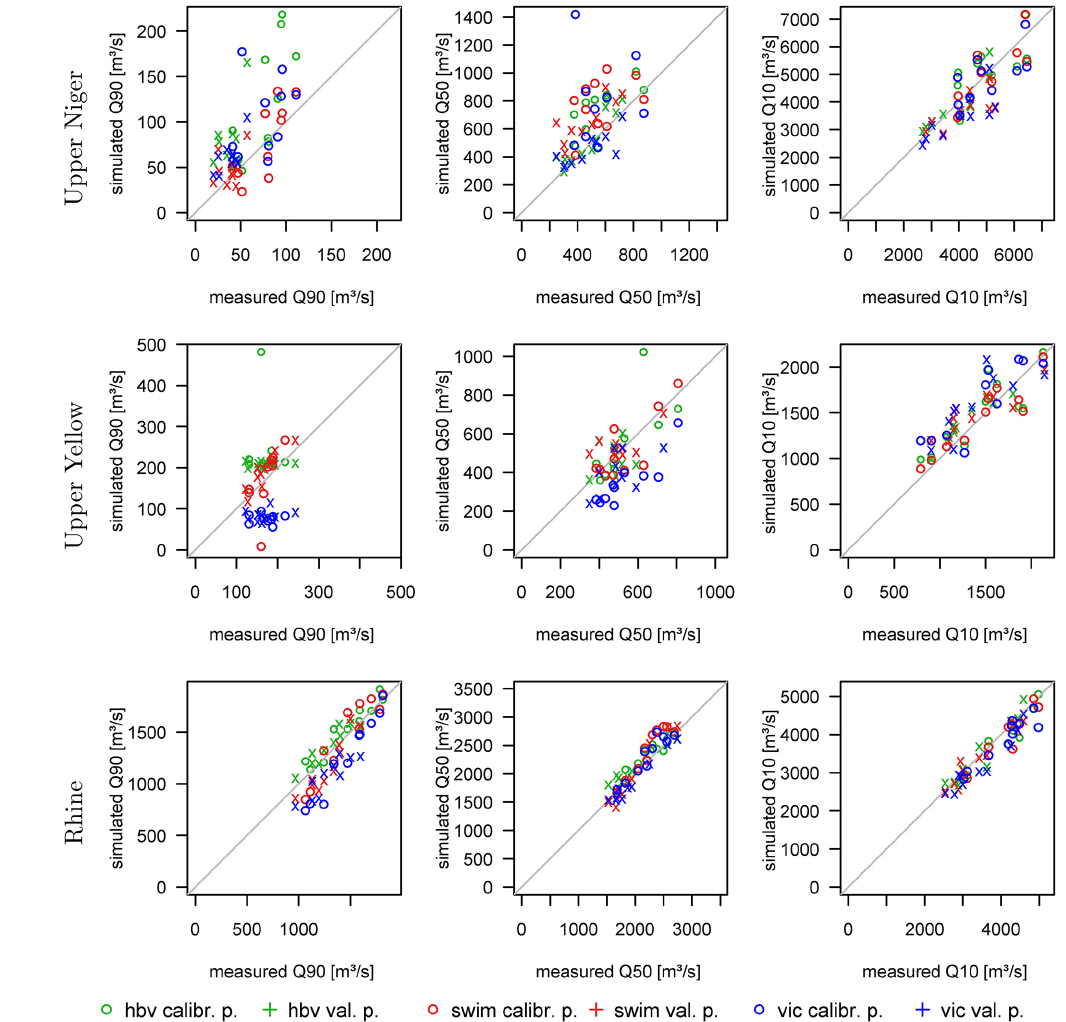
Figure 3. Comparison of simulated and observed annual values of Q 90 , Q 50 and Q 10 in the calibration and validation periods for three basins: the Upper Niger, Upper Yellow and